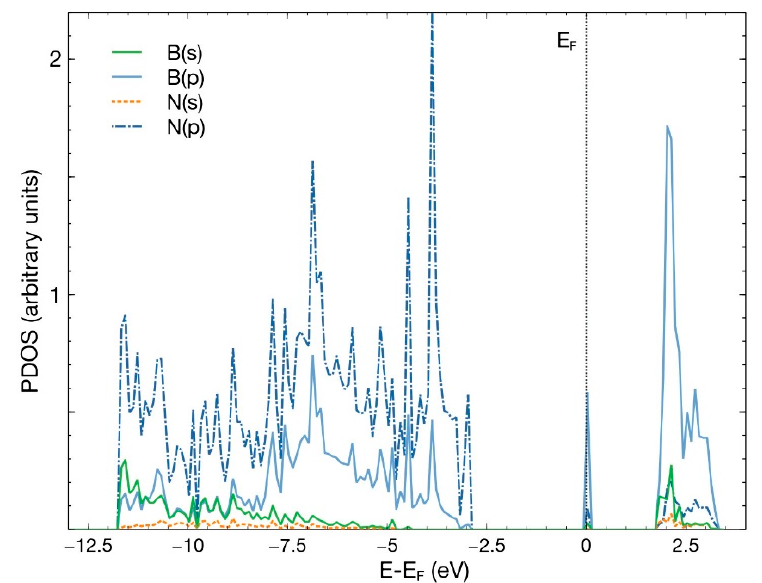
Figure 11. PDOS for the hBN surface with an N vacancy. The rearrangement of states and, therefore, of charge turns evident around the Fermi energy. The s and p orbitals of boron and nitrogen are shown.